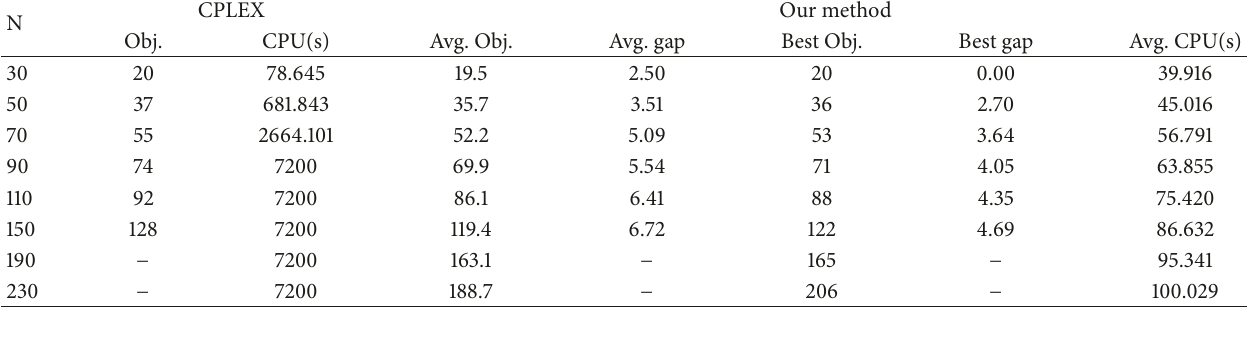
Table 4: Performance analysis of CPLEX and the clustering algorithm. K = 10.